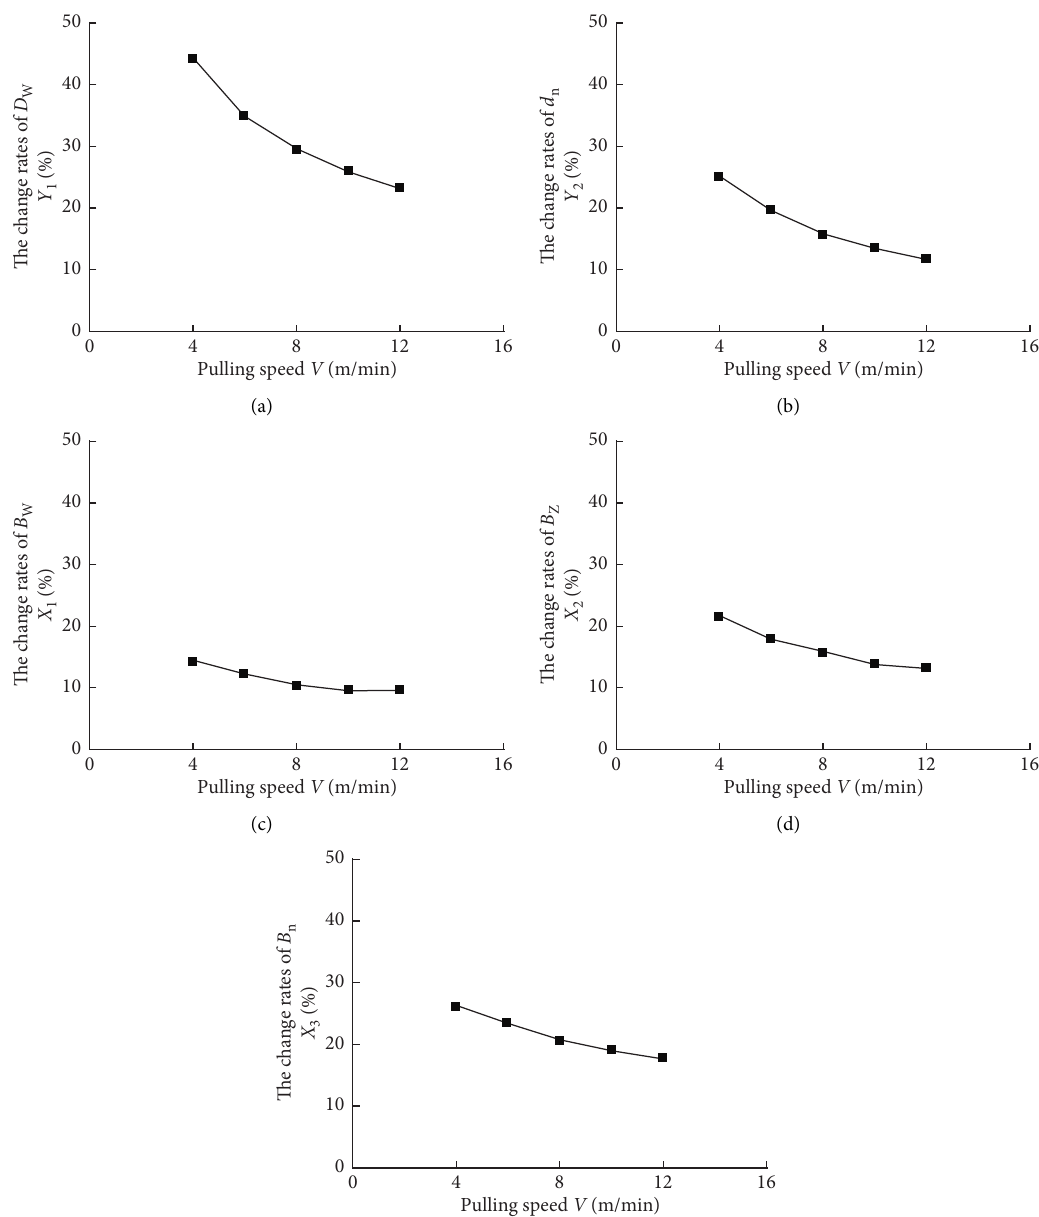
Figure 6: Diameter change rates ((a) outer and (b) inner diameter) and wall thickness change rates ((c) outer layer, (d) middle layer, and (e) inner layer wall thicknesses) of three-layered balloon catheters as a function of pulling